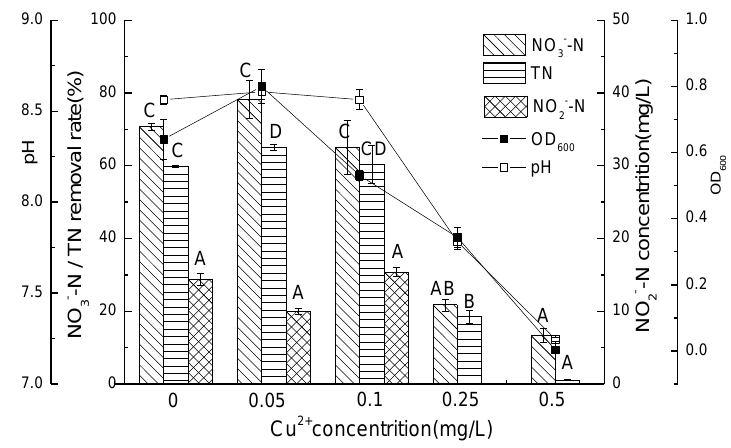
Figure 4. Effects of Cu 2+ on nitrate nitrogen removal performance of strain D51.